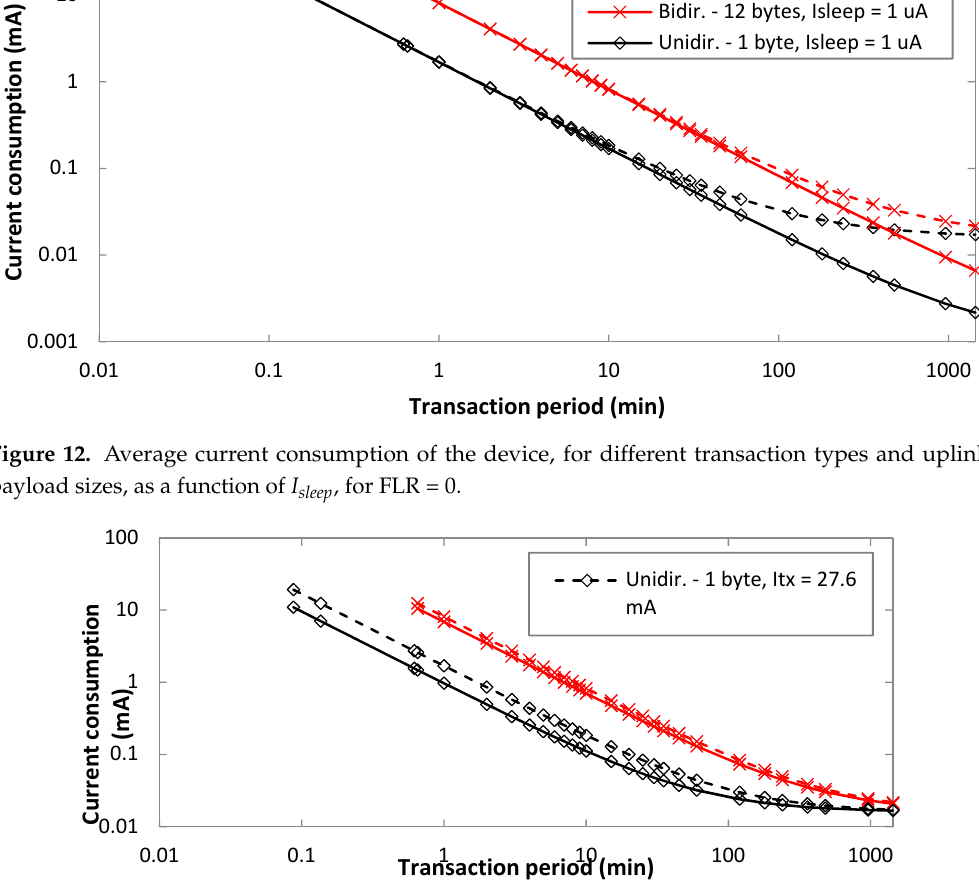
Table 4. Energy required and minimum feasible T Period for different types of transactions, for the two energy harvesting sources considered, and for an uplink bit rate of 100 bit/s. Transaction